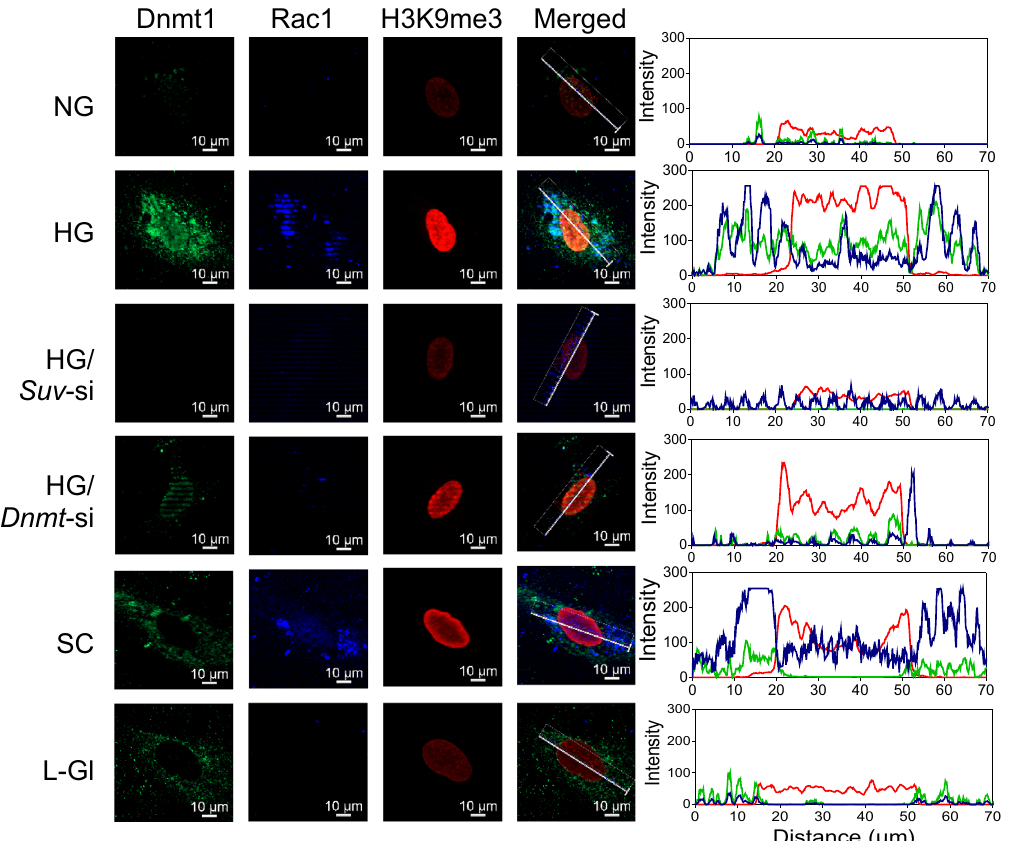
Figure 4. Effect of high glucose on localization of H3K9me3, Dnmt1 and Rac1. Immunofluorescence technique was used to determine co-localization of H3K9me3, Dnmt1 and Rac1 in HRECs. The images were captured by Zeiss microscope at 40 × magnification using the Apotome module. The line represents the region of interest used to quantify the arithmetic mean intensity per channel. The figure shows one representative cell/condition. Colors green, blue and red represent Dnmt1, Rac1 and H3K9me3,